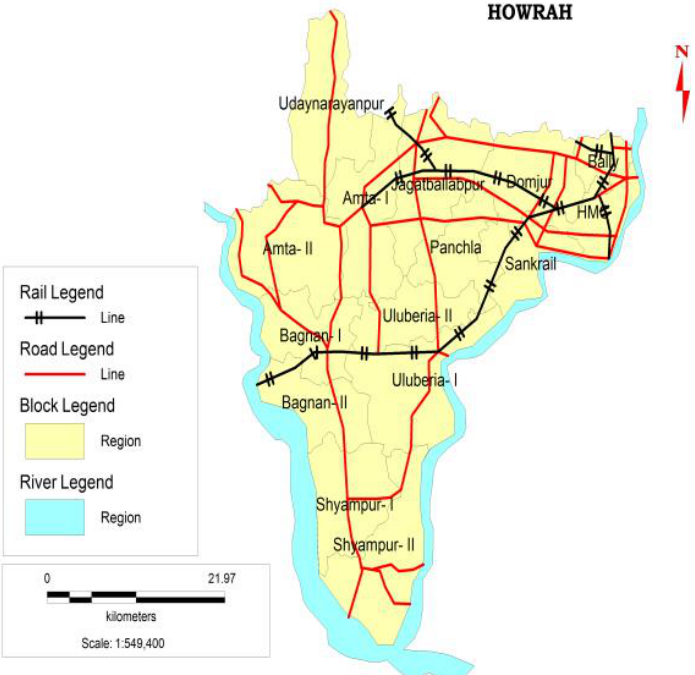
Figure 6. Transport Network in and around Howrah.